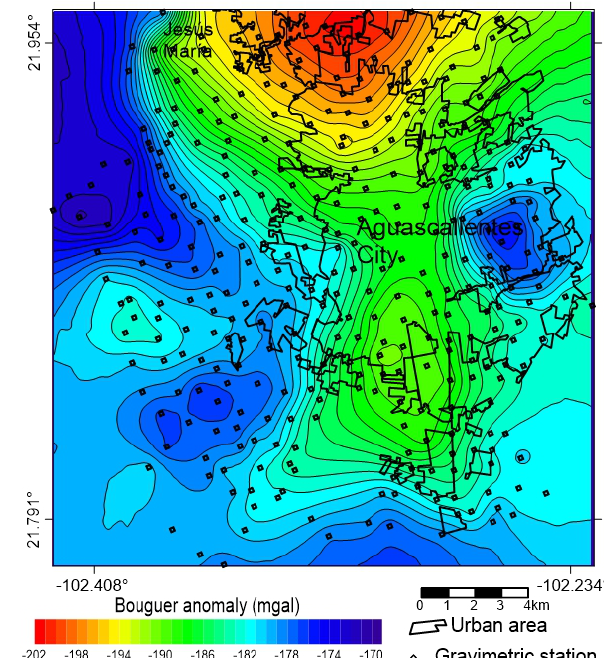
Figure 4. Complete Bouguer anomaly of the Aguascalientes city and